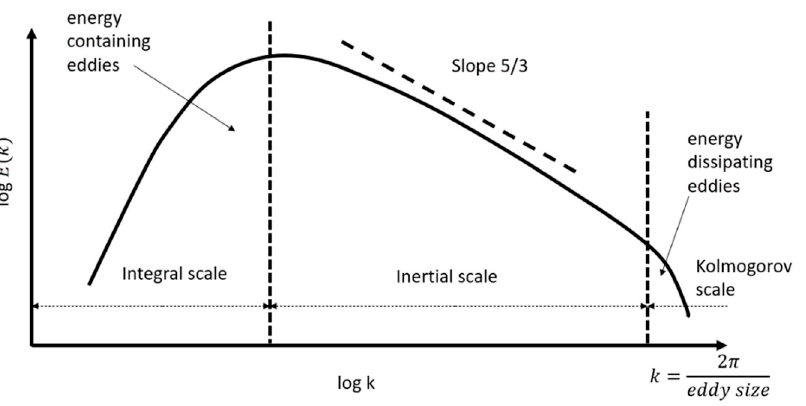
Figure 5. Turbulence eddy scaling. Reprinted with permission from [41]. 2021 Hanmaiahgari, P.R.